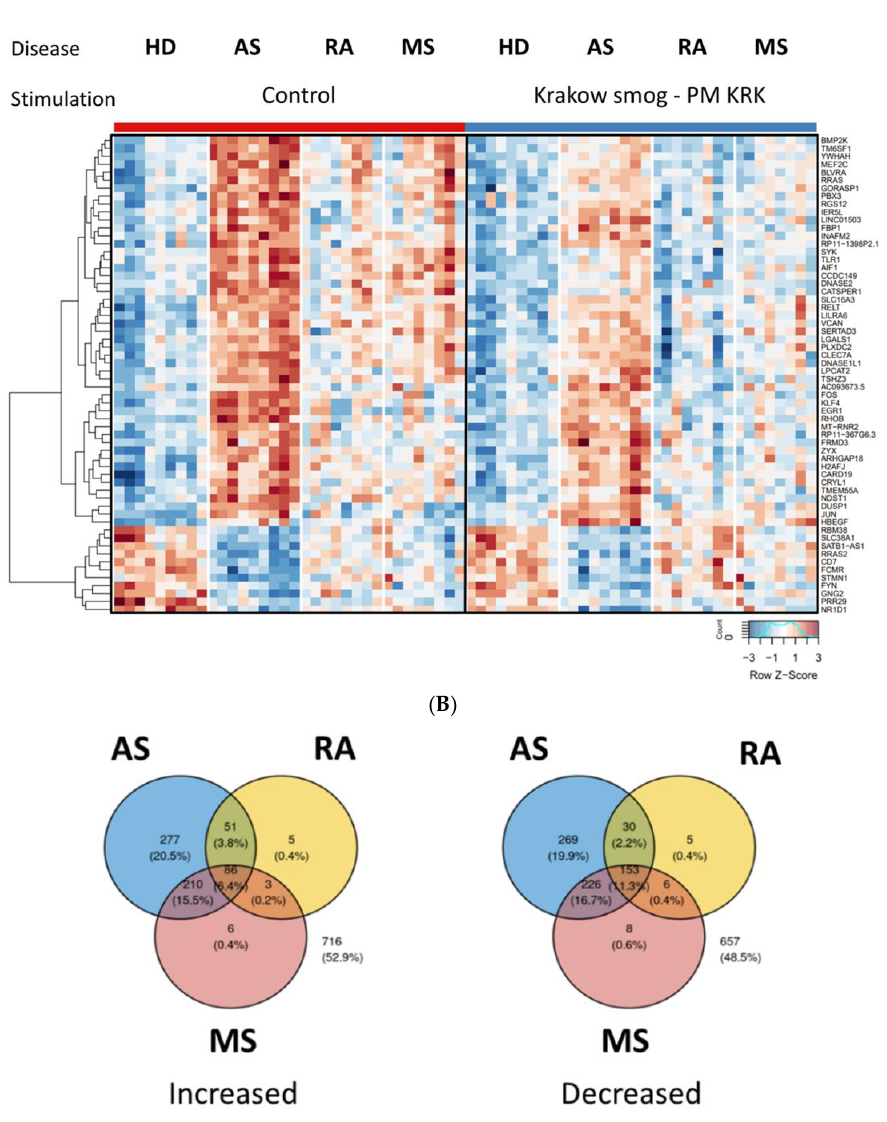
Figure 2. Gene expression differences between the PBMCs derived from healthy donors (HD) and patients with rheumatoid arthritis (RA), multiple sclerosis (MS), and atherosclerosis (AS). ( A ) RNAseq results are shown as a heatmap and include transcripts with a genome-wide significance from two-way ANOVA for the disease factor (FDR corrected p < 0.001) and the difference between control vs. disease group (a fold of change log 2 > 1). The intensity of the coloured rectangles represents transcript abundance levels. The presented level is proportional to the row z-score values (between − 3 and 3) as displayed on the bar below the heatmap image. Hierarchical clustering was performed using correlation as a distance measure. The full list of differentially expressed transcripts is presented in Table S1. ( B ) Comparison of the number of genes with expression altered by diseases. The results of ANOVA analysis for disease factor (threshold p < 0.01 FDR corrected) followed by post hoc test ( p < 0.01) between healthy and disease